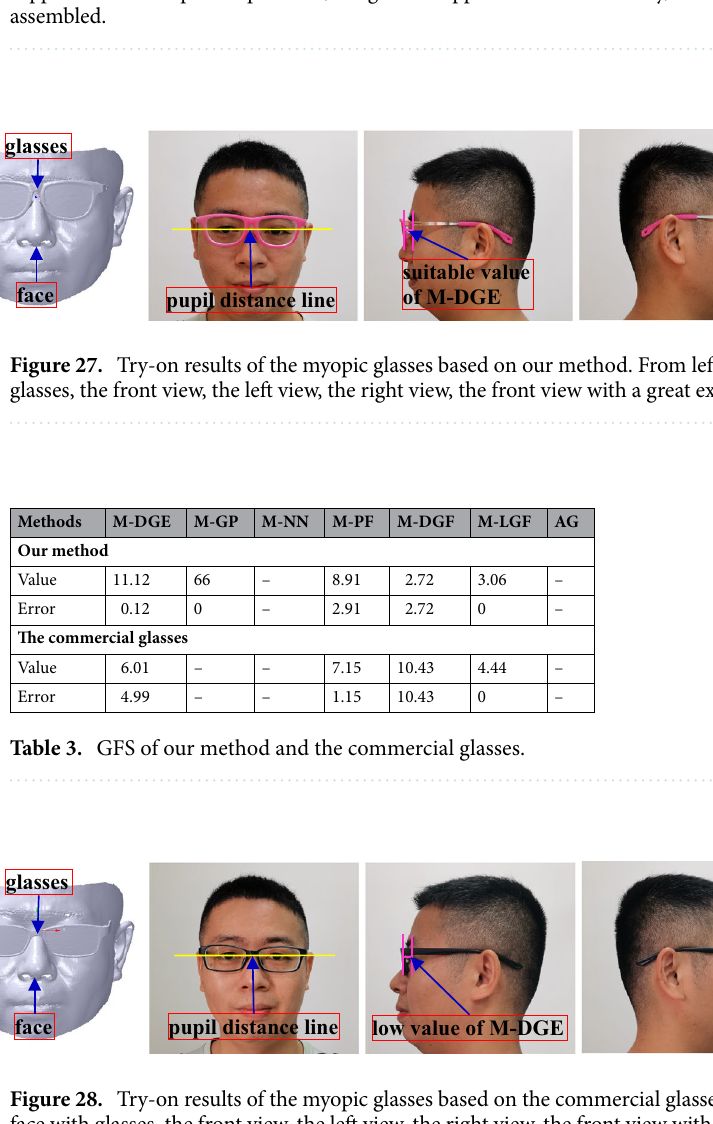
Figure 28. Try-on results of the myopic glasses based on the commercial glasses. From left to right: the scanned face with glasses, the front view, the left view, the right view, the front view with a great